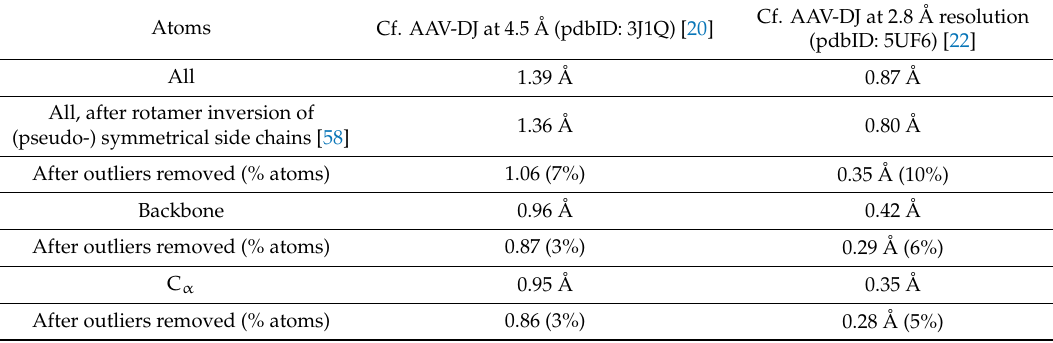
Table 3. Comparison with lower resolution cryo-EM structures (RMS di ff erences). For the 2.8 Å structure, both glycan-bound and unbound conformers were refined against a symmetrized partially bound reconstruction [22]. Compared here is the unbound conformer. Outliers are defined in the conventional statistical sense with di ff erences > 3rd quartile + 1.5 × (interquartile